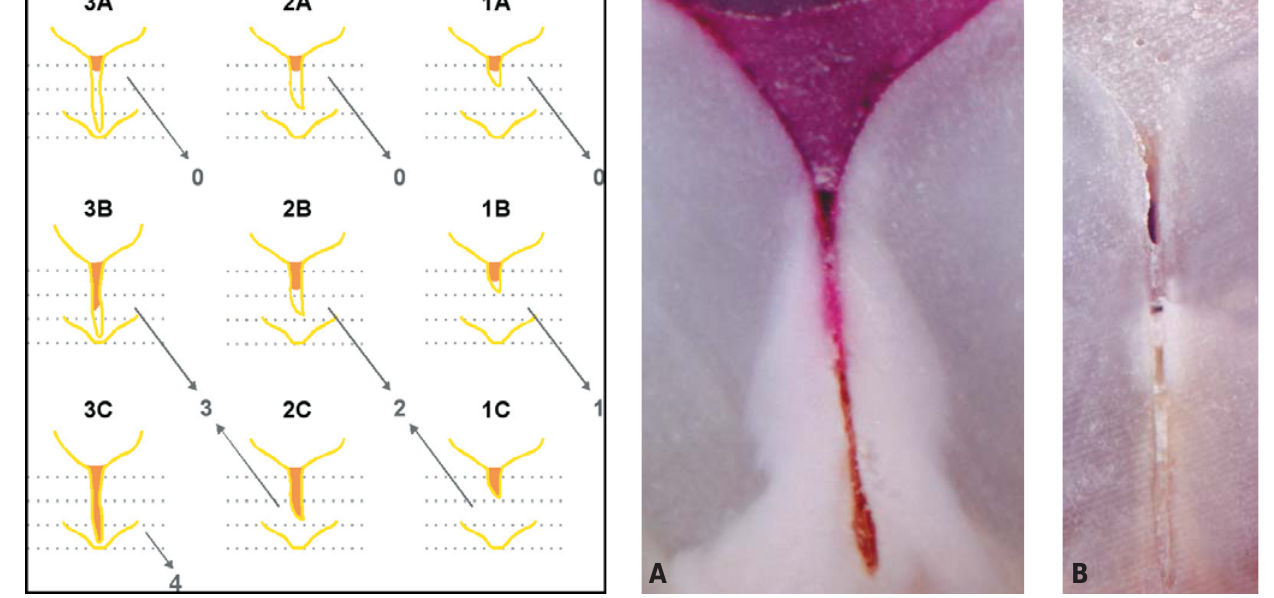
FIGURE 1 - (A) - Diagram of the scores according to the relationship between depth of fissure/sealant penetration